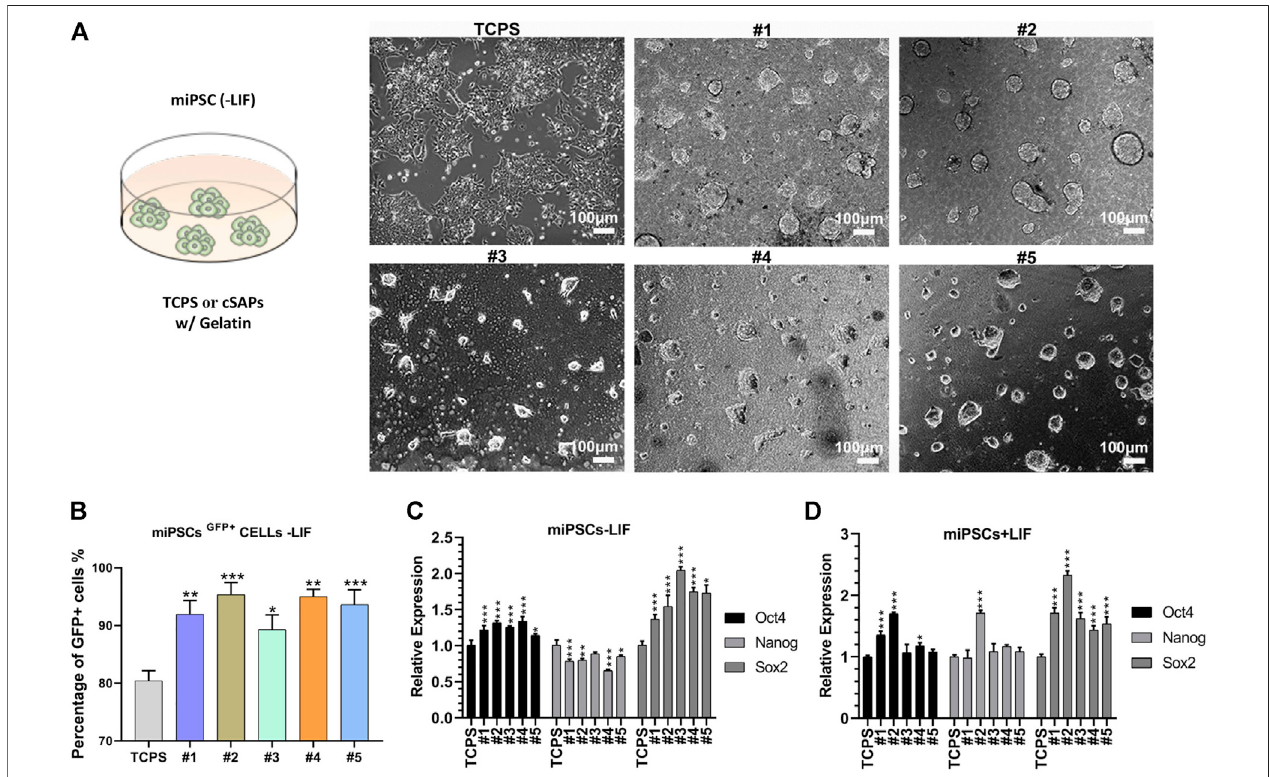
FIGURE2 | Pluripotency ofmiPSCs ondifferentsubstrates coated withgelatin. (A) Colonymorphology ofmiPSCs cultured ondifferentsurfacesafter day 3. Scale bar (cid:1) 100 μ m. (B) FACS analysis of the Oct4+ cells without LIF. qPCR analysis of pluripotent markers, Oct4, Nanog, and Sox2 (C) without and (D) with LIF. Samples were triplicates ( n (cid:1) 3). Error bar (cid:1) STDEV.